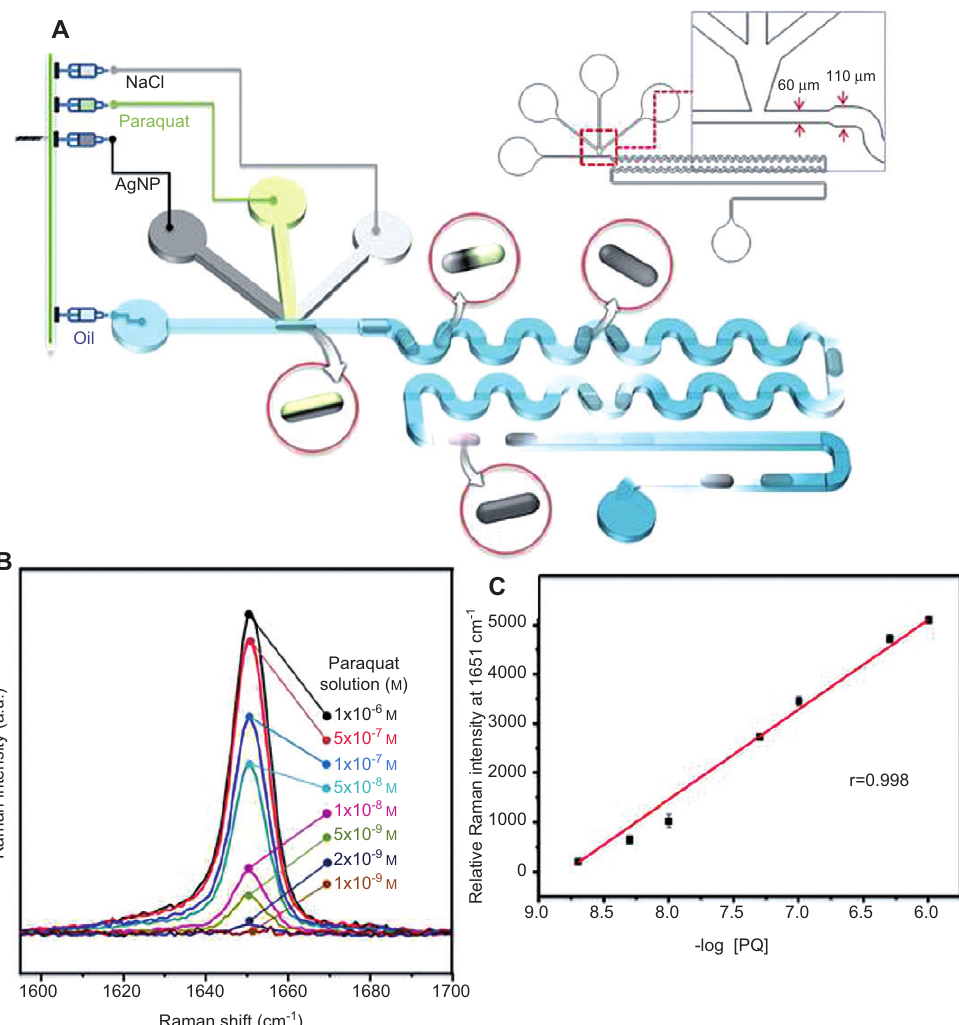
Figure 5 (A) Schematic illustration of a microdroplet channel for SERS detection. (B) SERS spectra of paraquat in a PDMS microdroplet channel at different concentrations. (C) Variations of the peak intensity at 1651 cm -1 of SERS spectra as a function of the paraquat concentra- tion. Reproduced with permission from: Gao et al. (2010) . Copyright 2010,